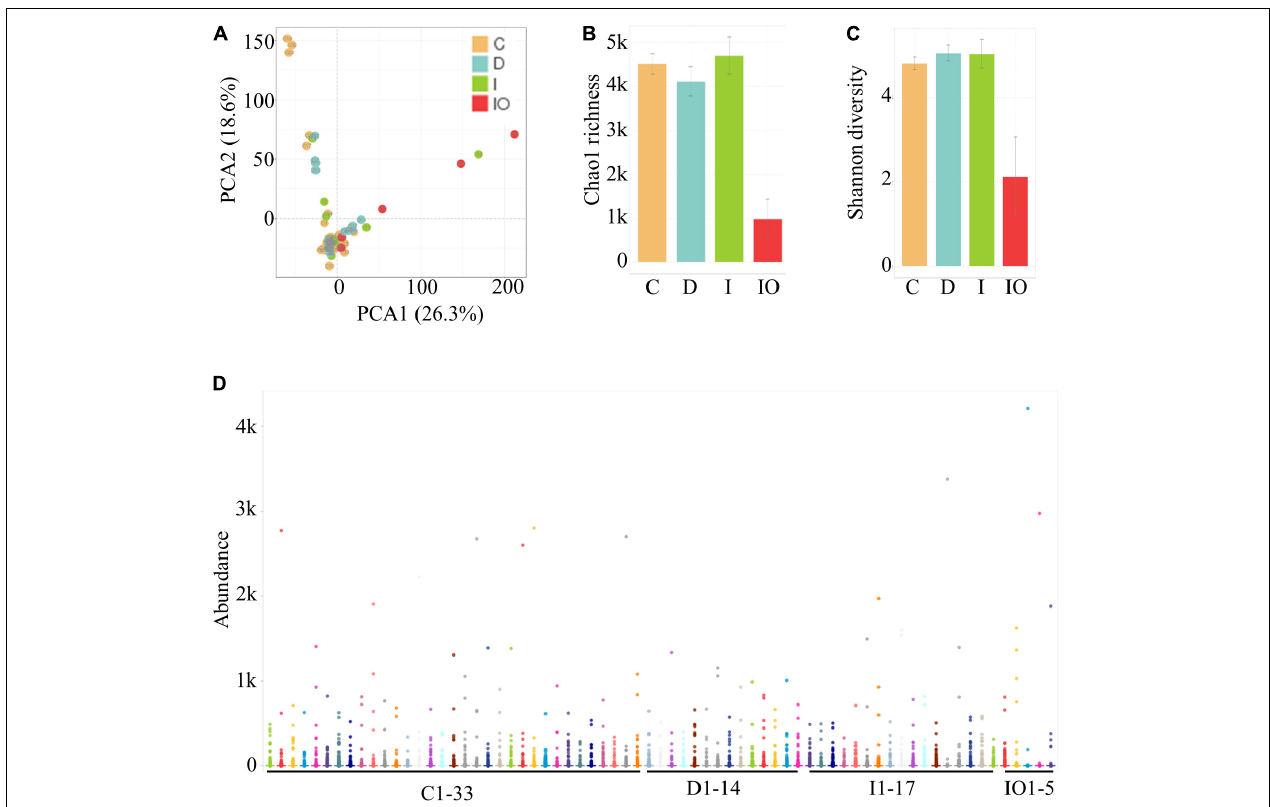
FIGURE 1 | Identification and quantification of OTUs among 69 samples in this study. (A) PCA for all samples. (B) Representation of the microbiota richness (B) and diversity (C) of four clinical groups. C, Healthy individuals; D, CRC patients after chemotherapy; I, CRC patients before treatment; IO, CRC patients after surgical debulking. (D) Distribution of the microbial abundance for all